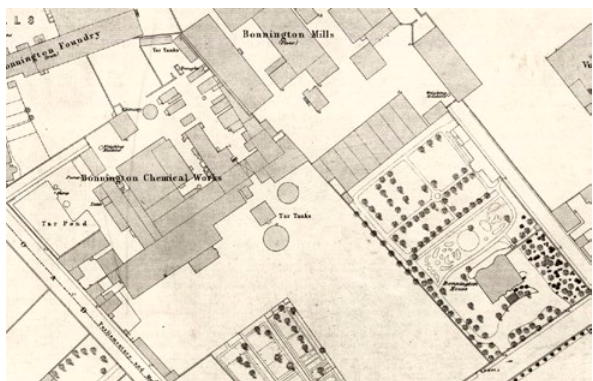
Figure 3. Bonnington chemical works near Edinburgh. Bonnington House is at the southeast corner of the overall site. Source: Ord- nance Survey, Edinburgh, Sheet 16, 1876, National Library of Scot-